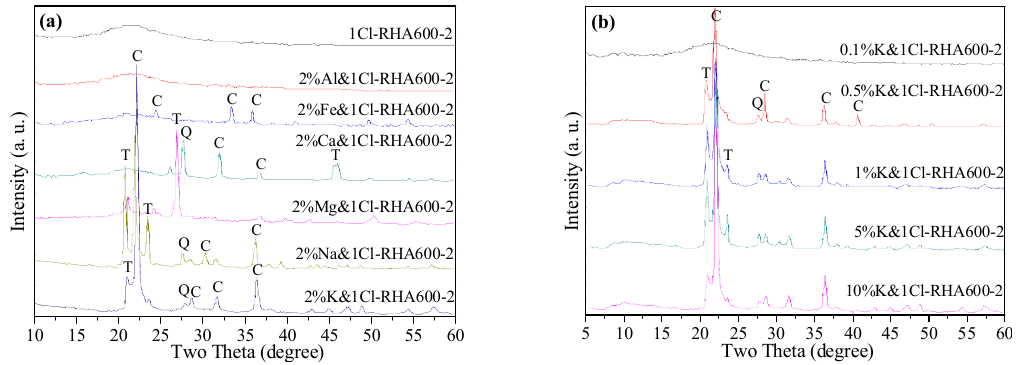
Figure 8. XRD spectra of ( a ) the mixture of HCl-pretreated RH and chlorine salts after burning out at 600 °C for 2 h; ( b ) the mixture of HCl-pretreated RHA silica various dosage of KCl after burning out at 600 °C for 2 h. (C = cristoballite; Q = quartz; T = tridymite).